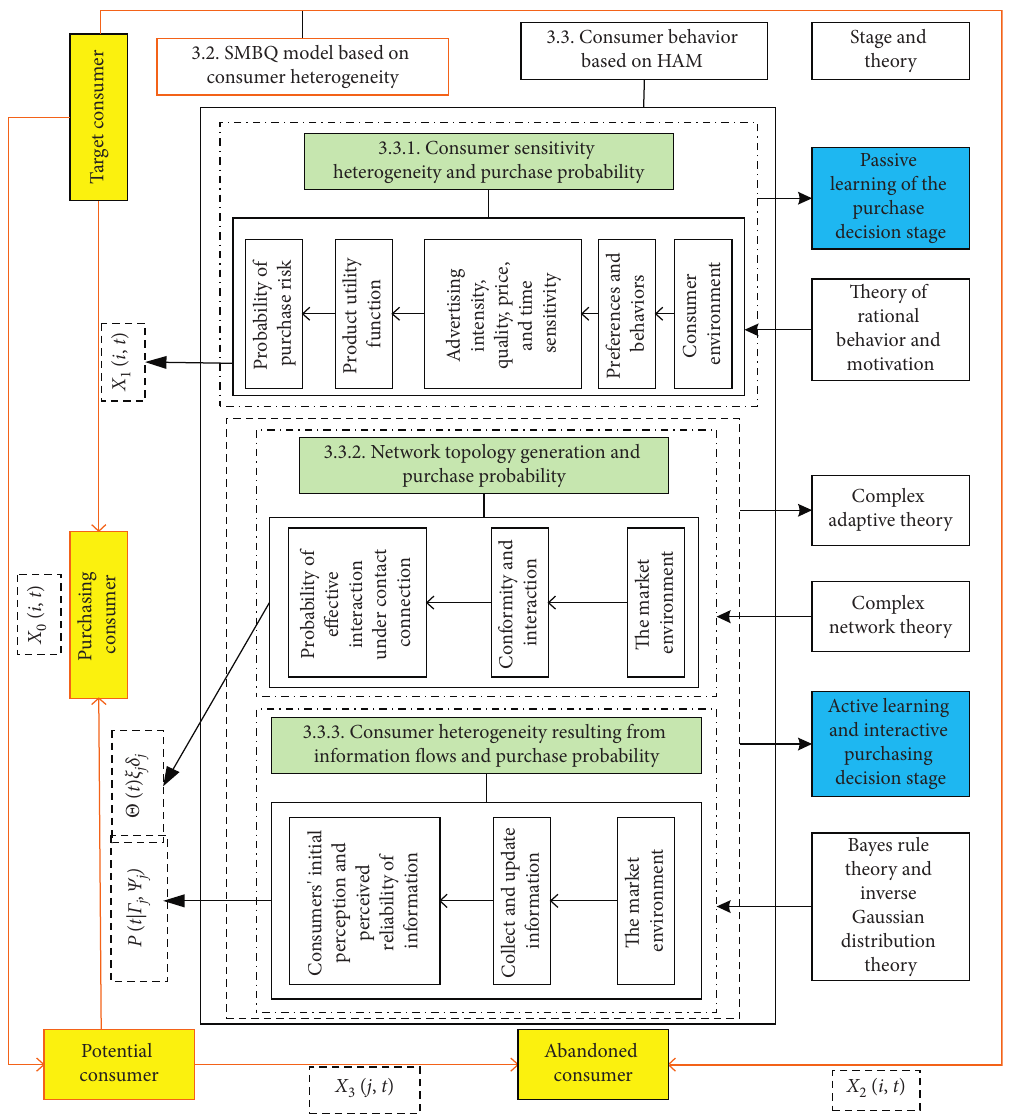
Figure 1: Coupling model framework based on a combination of the SMBQ model and the heterogeneous agent model (HAM).